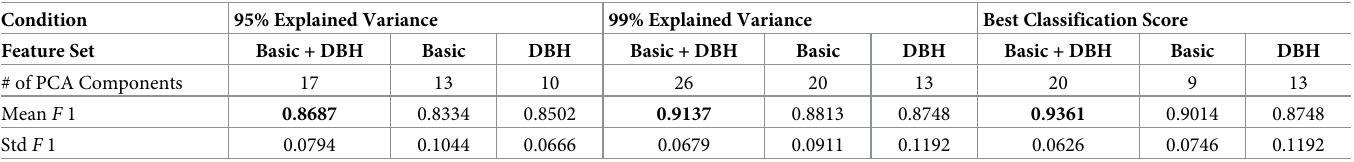
Table 6. The results of the linear SVM of the three groups of feature types (Base + DBH, Base, and DBH). Condition 95% Explained Variance 99% Explained Variance Best Classification Score Feature